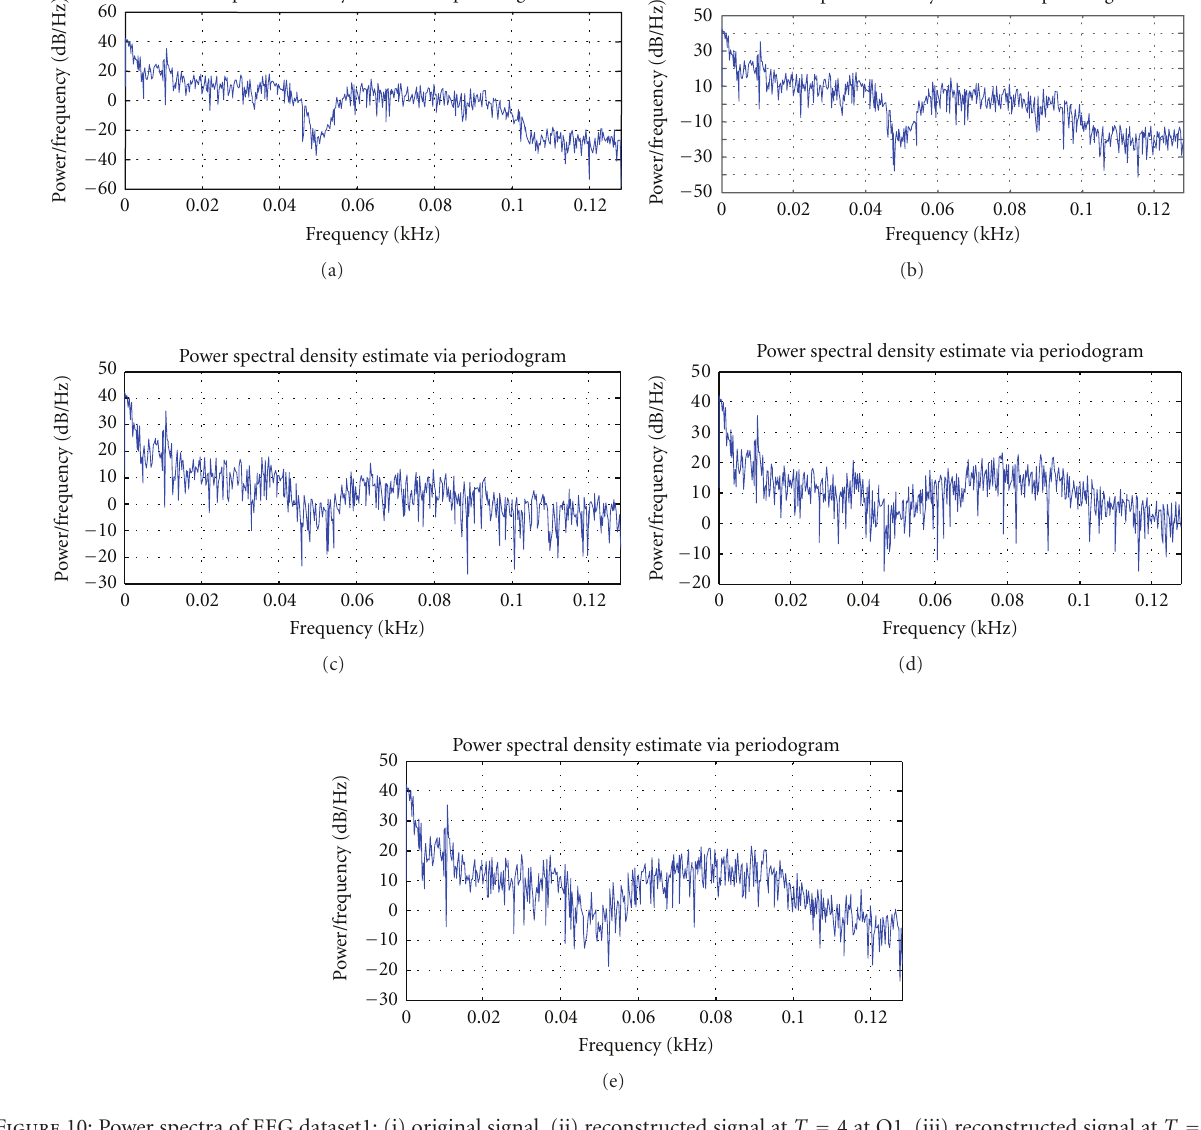
Figure 10: Power spectra of EEG dataset1: (i) original signal, (ii) reconstructed signal at T = 4 at Q1, (iii) reconstructed signal at T = 7 at Q1, (iv) reconstructed signal at T = 4 at Q2, and (v) reconstructed signal at T = 3 at